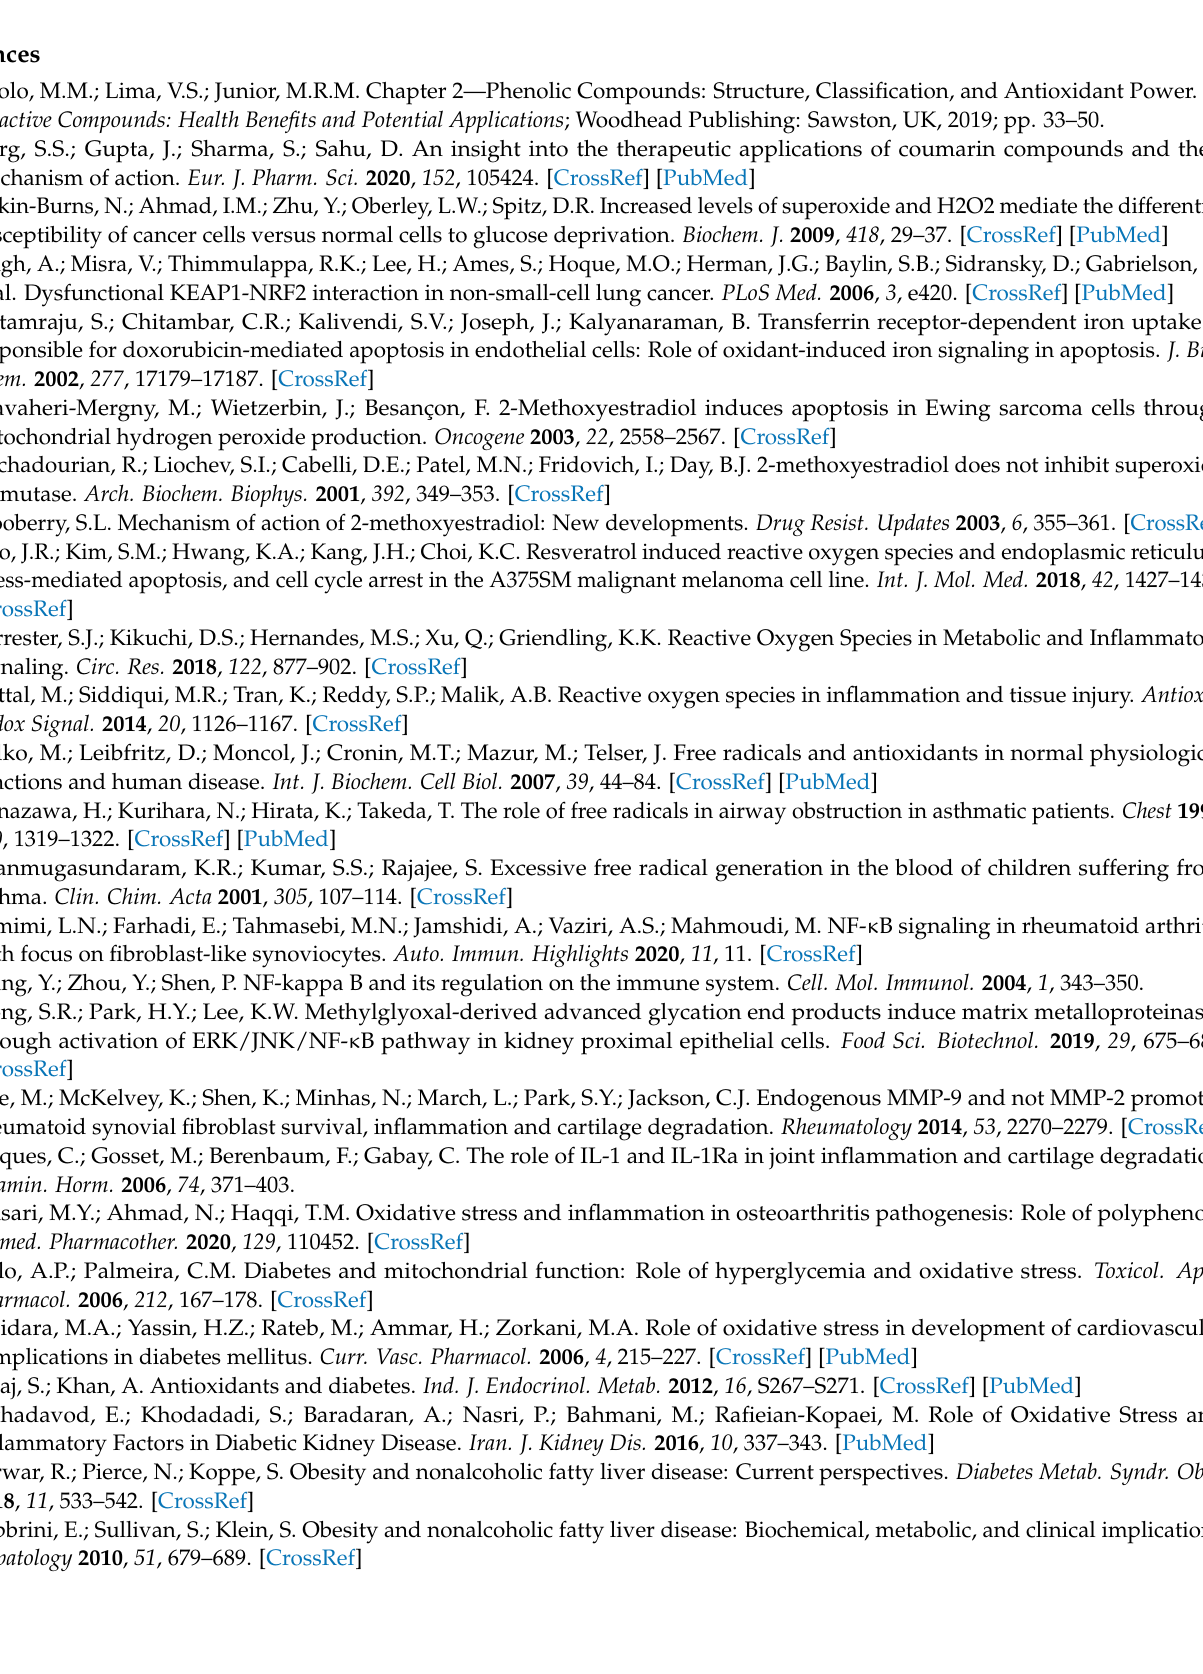
Feruloyl CoA6 (cid:48) -hydroxylase; HPLC: High performance liquid chromatography; HPLC-DAD-ESI-MS: HPLC-diode array UV-detection-electrospray ionization tandem mass spectrometry; RP-HPLC: Re- verse phase-HPLC; C max : Maximum plasma concentration; T max : Time to reach maximum plasma concentration; T 1/2 : elimination